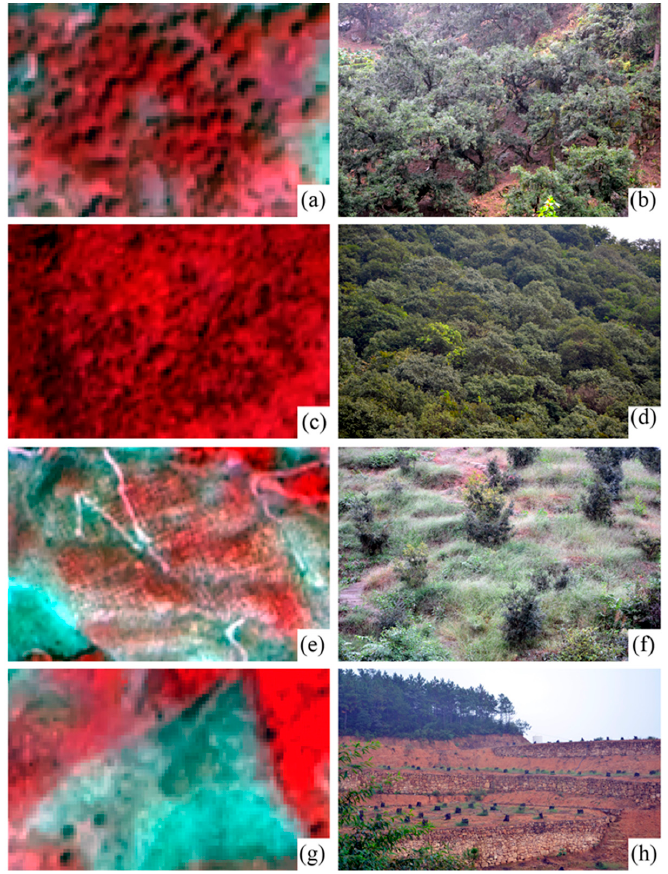
Figure 8. A comparison of different land-cover compositions in the GF-1 satellite color composites and corresponding photos (( a , b )—old Torreya forests; ( c , d )—broadleaf forests; please note the shadows from old Torreya forests and from broadleaf forest; ( e , f )—young Torreya plantations with some grass cover and bare soil; ( g , h )—new Torreya plantations with abundant bare soil).